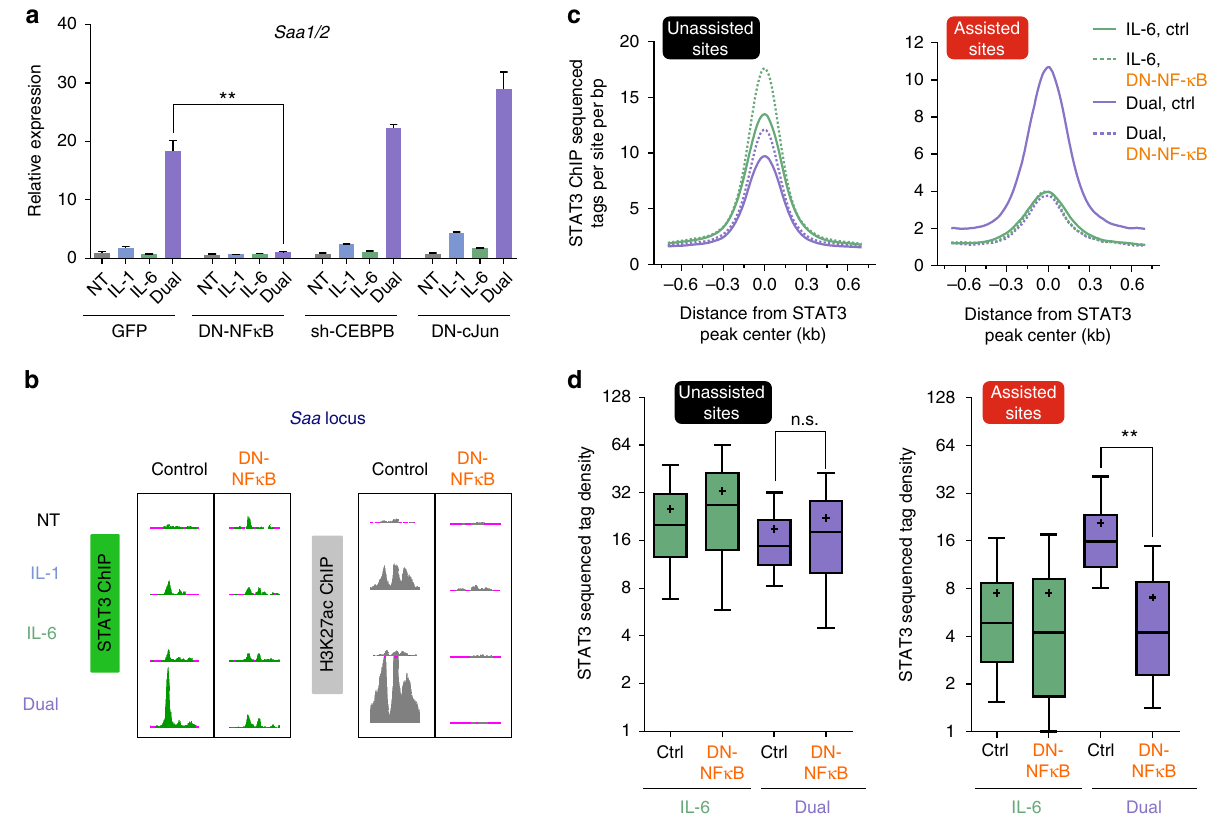
Fig. 6 NF- κ B is responsible for IL-1 β -mediated assisted STAT3 binding and synergistic gene expression. a Nascent RNA levels of Saa1/2 in primary hepatocytes pre-treated with adenovirally-expressed inhibitors of IL-1 β -activated TFs. Representative experiment shown of at least three independent repeats. Error bars represent s.d. of three technical replicates. b Genome browser tracks depicting STAT3 assisted loading as well as enhancer priming at the Saa1/2 locus are negated in the presence of a dominant negative peptide inhibiting NF- κ B activity (DN-NF κ B). c , d The IL-1 β -dependent increase in STAT3 binding at assisted sites is negated in the presence of a dominant negative peptide inhibiting NF- κ B activity. Asterisks denote statistical signi fi cance as determined by an unpaired, two-tailed t-test. Single asterisk denotes p -value ≤ 0.05, double asterisks denote p -value ≤ 0.01. NS denotes not signi fi